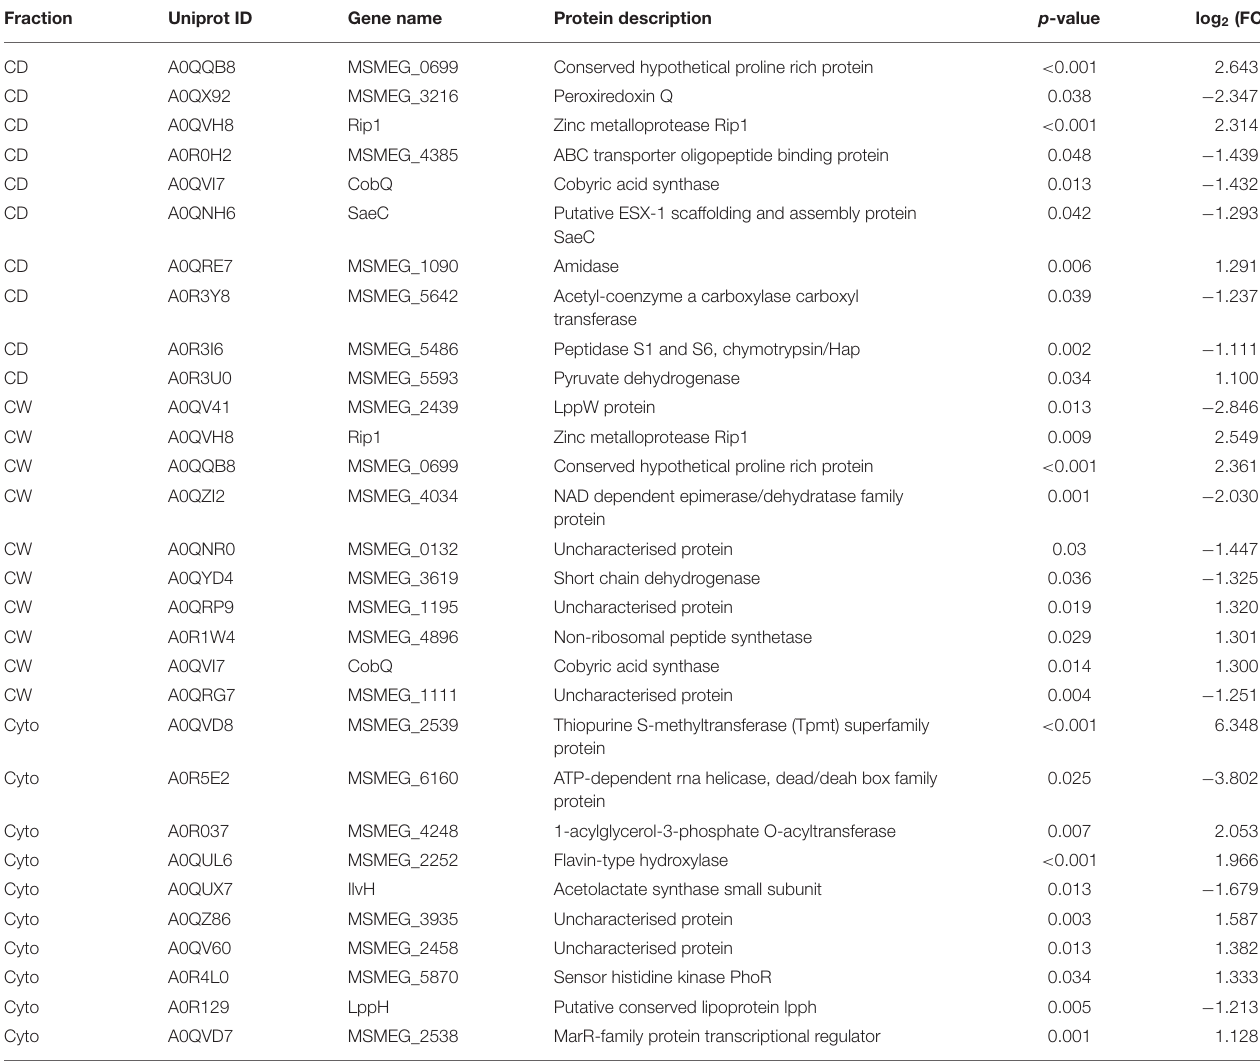
TABLE 1 | Top-10 most dysregulated SL proteins by cellular fraction.